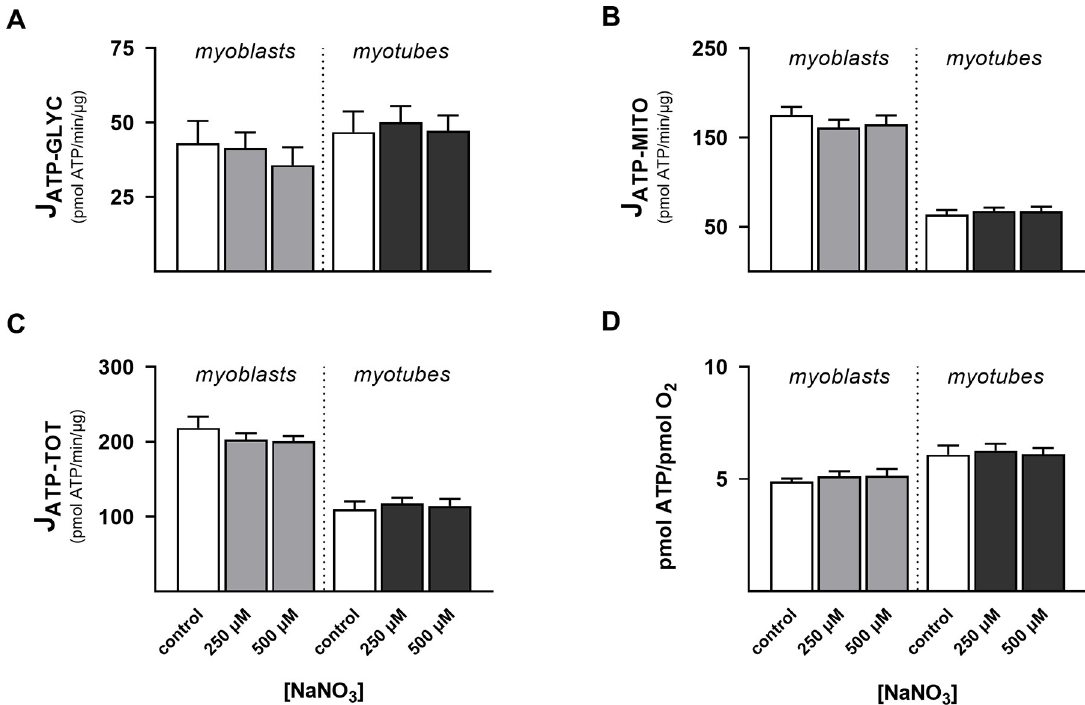
Fig 6. Nitrate effects on ATP supply. Rates of mitochondrial, glycolytic and total ATP supply (J ATP,MITO , J ATP,GLYC and J ATP,TOT , respectively) in static myoblasts and spontaneously contracting myotubes were calculated from oxygen uptake and medium acidification data obtained after a ½ -hour exposure to NaNO 3 . Data are means ± SEM of 13–18 well measurements sampled from 4 independent XF assays. NaNO 3 effects were evaluated for statistical significance by combined Kruskal-Wallis and Dunn’s tests and were found non- significant.